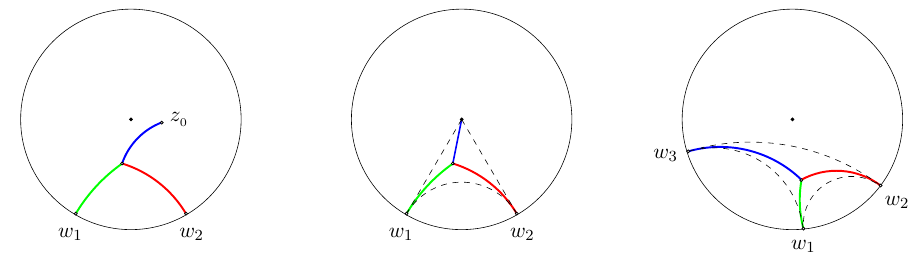
Figure 3 . Trivalent vertex (Fermat-Toricelli point) of a Steiner tree on the hyperbolic plane. All segments have di ↵ erent weights that is indicated by di ↵ erent colors.